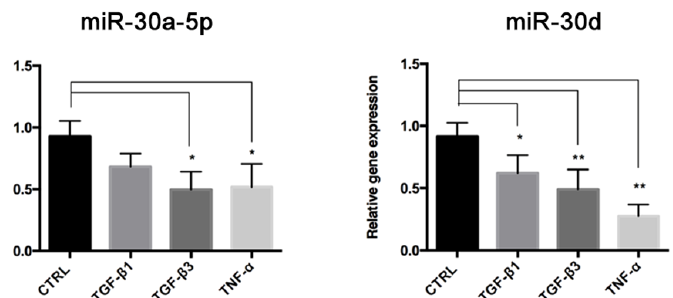
Figure 7. miR-30a-5p and miR-30d are downregulated during End–MT. Relative expression of miR-30a-5p and miR-30d in HUVECs after 6 days of exposure to TGF- β 1, TGF- β 3 and TNF- α . Results are reported as fold changes relative to the untreated group. All data are expressed as mean ± SD of at least 3 independent experiments, and statistical analysis was performed by unpaired Student’s t test. * p < 0.005; ** p < 0.001. miR-NC, miRNA negative control.